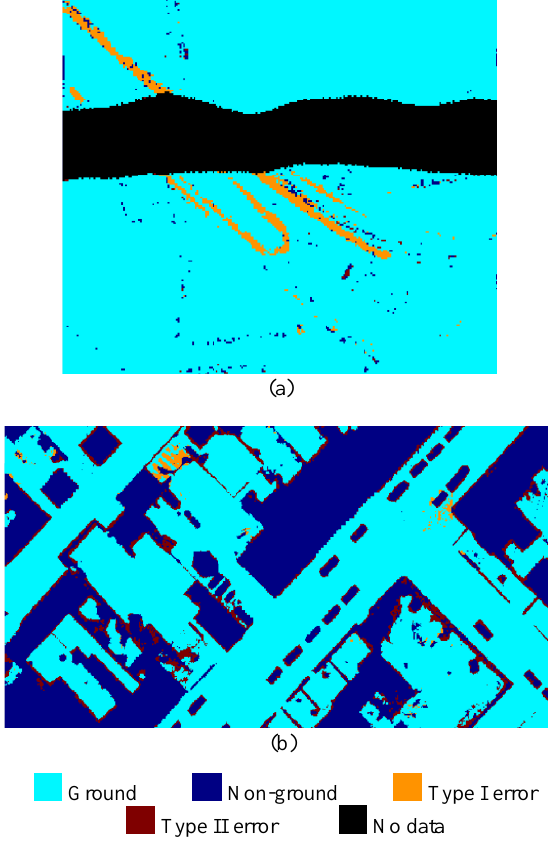
Figure. 5. Error distribution in filtering of the LiDAR datasets. (a) ISPRS, (b) IEEE